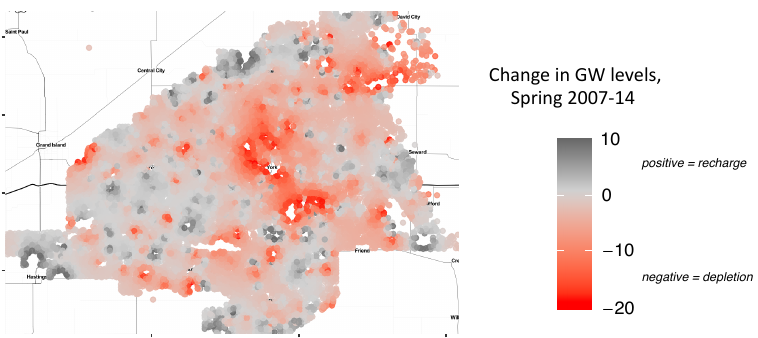
Figure 2. Well-per-well change in water table levels (i.e., groundwater levels) from Spring 2017–14 in the Upper Big Blue